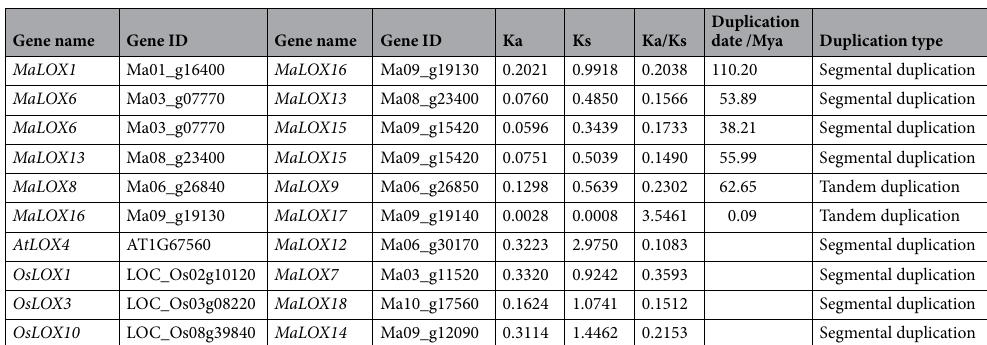
Table 2. LOX gene family intraspecific and interspecific gene replication